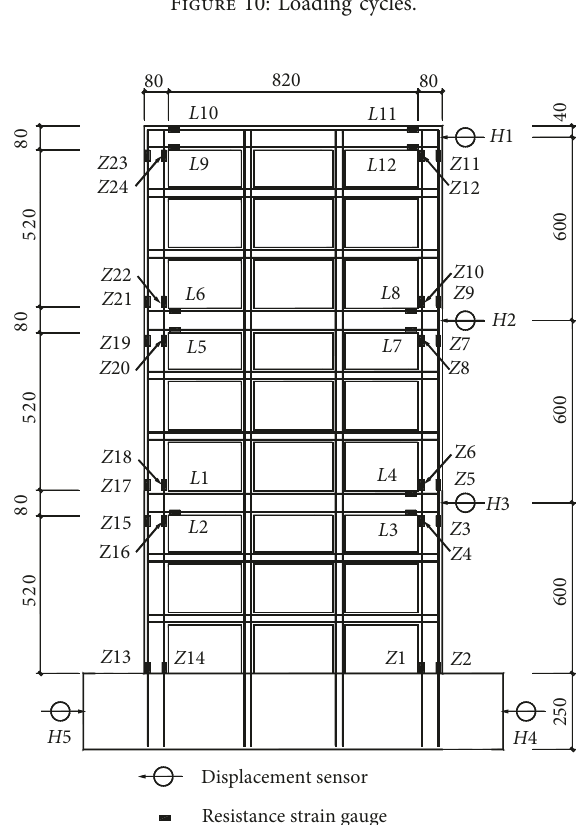
Figure 11: Layout of measuring